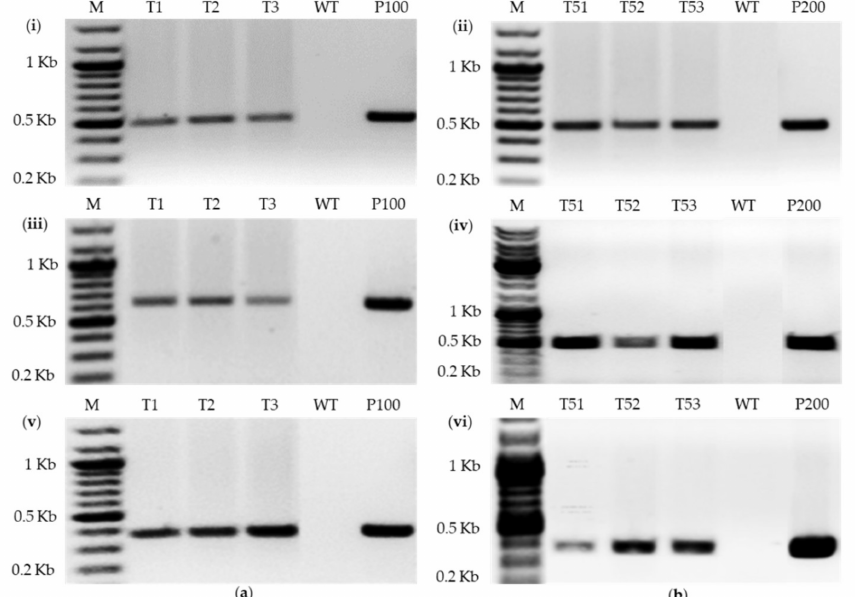
Figure 4. Confirmation of transgene insertion into E. gracilis cells. PCR-based confirmation for transforming ( a ) pWEN 100 and ( b ) pWEN 200 into E. gracilis . PCR analysis with hptII